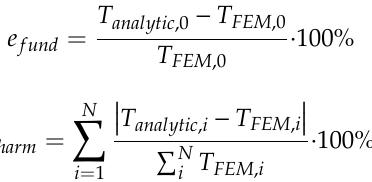
Figure 4. Distribution of the key indicator, 𝑒 (cid:3035)(cid:3028)(cid:3045)(cid:3040) , for the value of harmonics in torque For both 𝑒 (cid:3033)(cid:3048)(cid:3041)(cid:3031) and 𝑒 (cid:3035)(cid:3028)(cid:3045)(cid:3040) , the results show a dependence on the injected current level, 𝐼 (cid:2869) . For the constant value, the analytical calculation deviates in the negative direction from the FEM simulations, and for the harmonics it deviates in a positive direction. There is hardly any influence on the results from the variation in the frequency. However, the values show a wide scattering. For the change of the phase angle, the results show a strong variation. The scattering of the other parameters, when the phase angle is fixed, is, however, small. The deviations in the key indicators lie between 1% and 16%. The closer examination of a single operating point should show the convenience of the key indicator for the analytical calculation of the torque with reluctance torque for IPMSM, compared to an analytical calculation without reluctance torque. Figure 5 shows the time course of the torque for the operating point 𝐼 (cid:2869) = 40 𝐴 , 𝑓 (cid:3032) = 200 𝐻𝑧, 𝛾 (cid:2869) = 0.5 𝑟𝑎𝑑 from the FEM calculation, as well as the analytical calculation of the torque from Equation (15), once with 𝑇 (cid:3045)(cid:3032)(cid:3039) and once without. Figure 6 shows the corresponding spectrum of the torques.